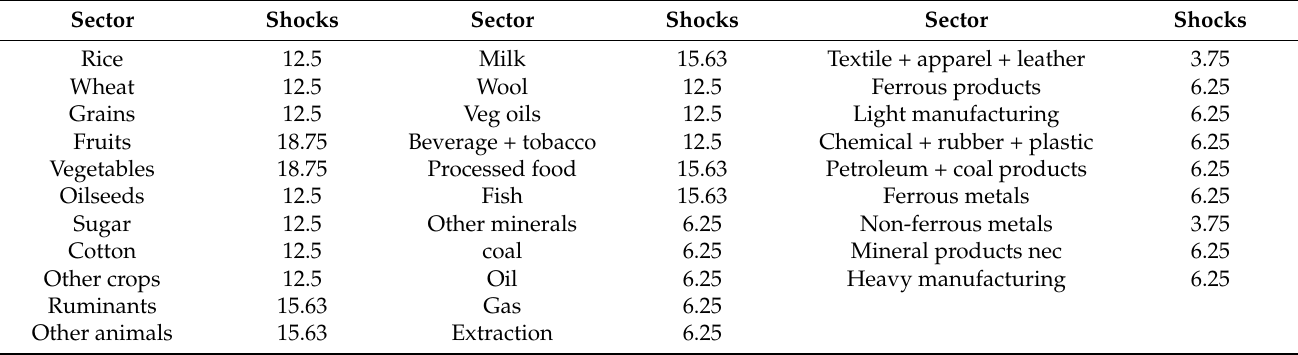
Table 1. Land rout Price Shocks to Exports from Pakistan (%)